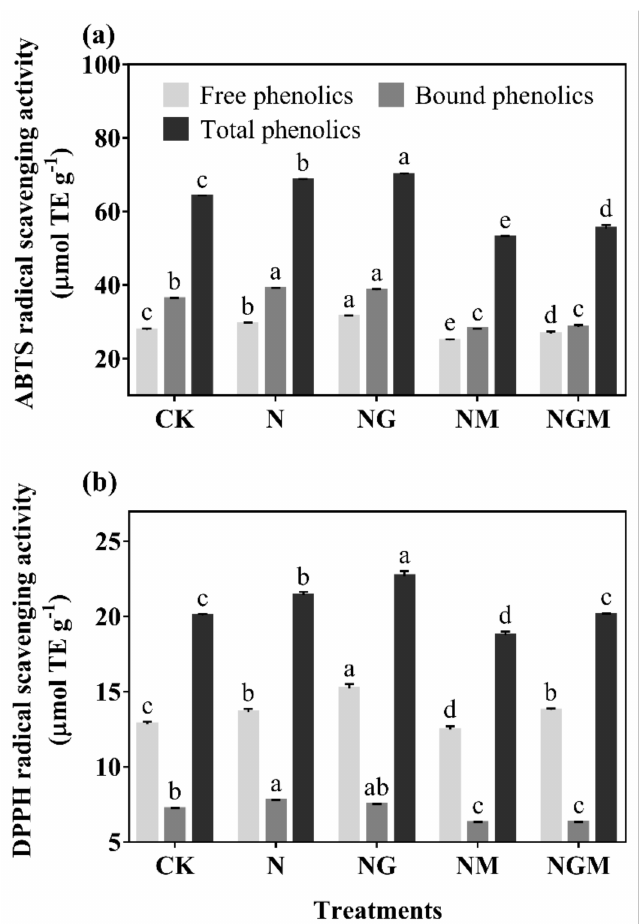
Figure 4. The effect of GABA on the ABTS ( a ) and DPPH ( b ) radical scavenging capacities in 6-day- old barley seedlings under 20 mmol L − 1 NaCl. The lower case letters indicate significant differences at p < 0.05 among different treatments. One-way ANOVA was used. The data are presented as mean ± SD, n =